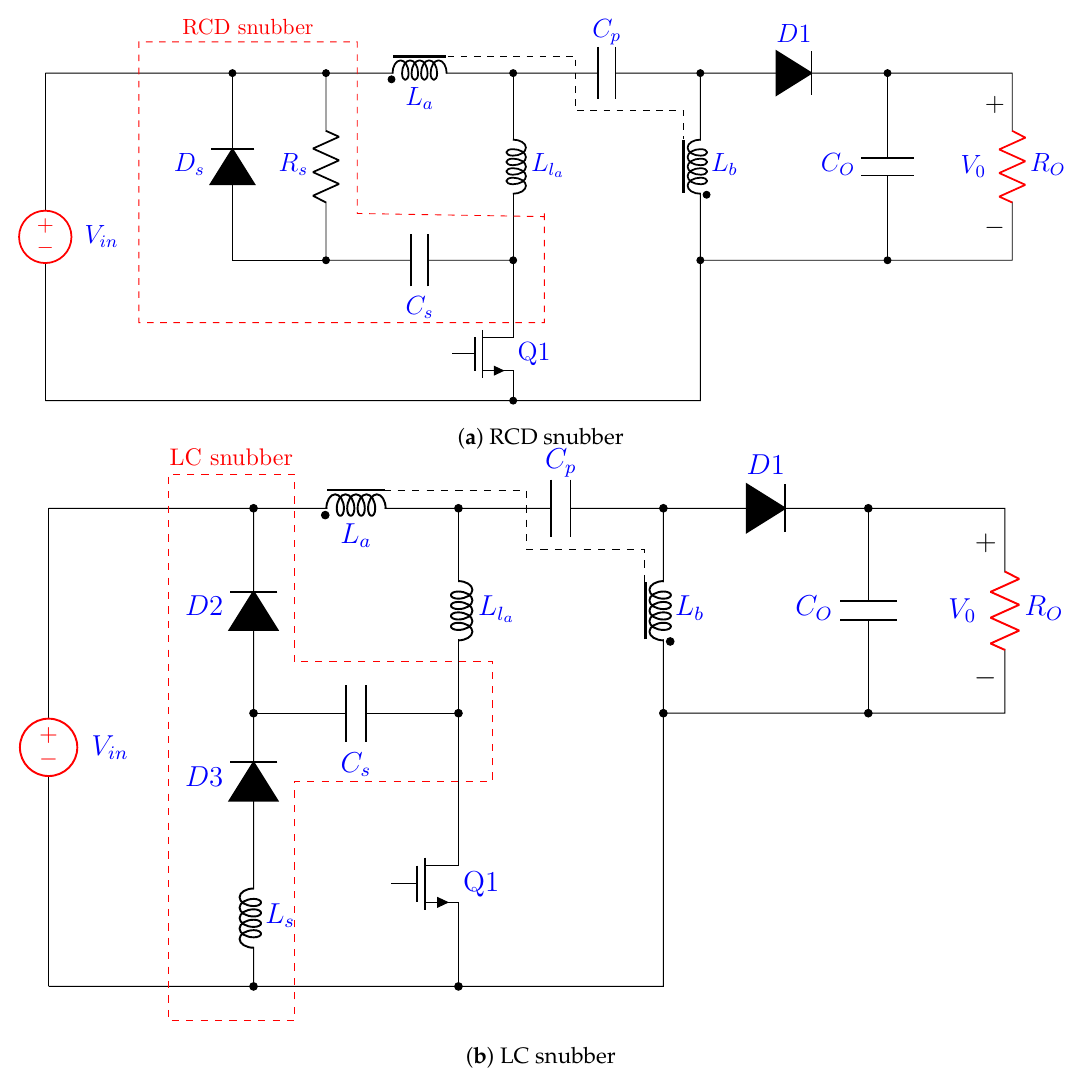
Figure 2. SEPIC converter with a ( a ) RCD snubber and ( b ) LC